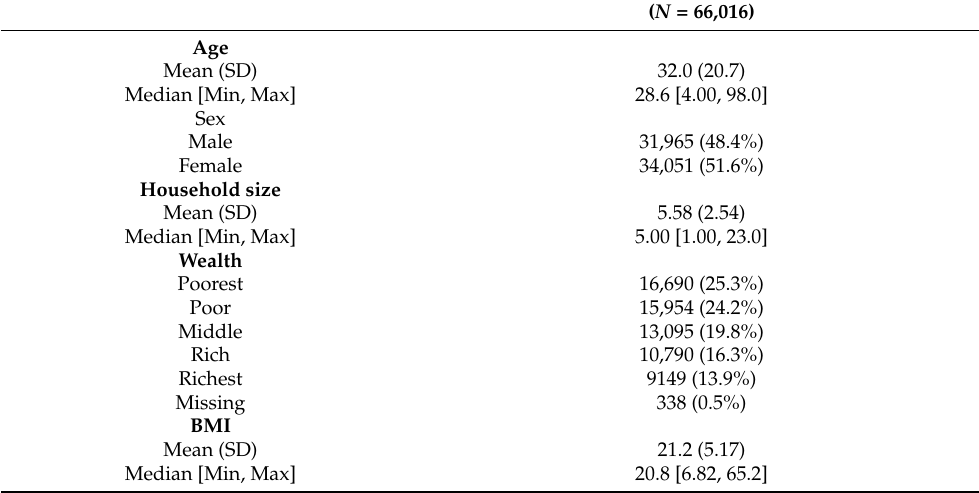
Table 5. Description of the population.